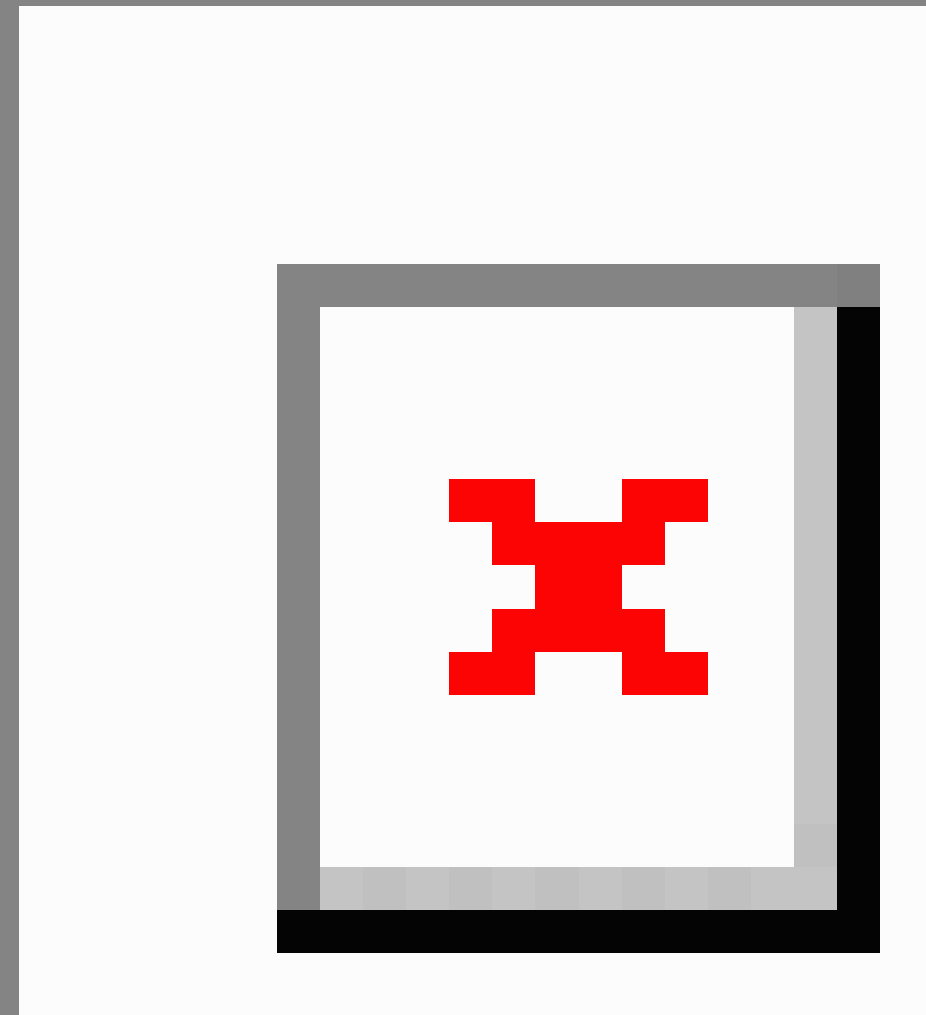
Figure 8. Identification of the interface